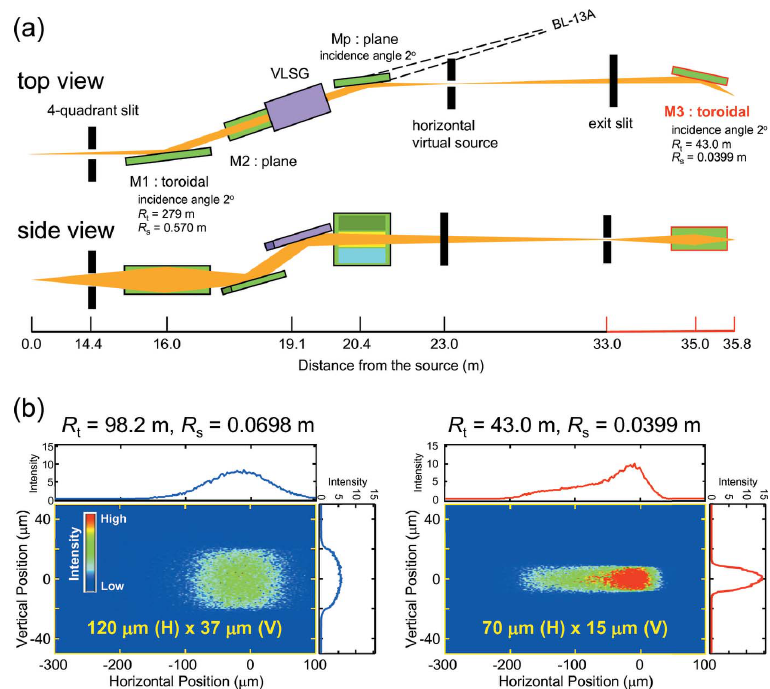
Figure 3 ( a ) Schematic optical layout of BL-13B. ( b ) Spot sizes at focal positions for the two toroidal focusing post-mirrors estimated by ray-tracing simulations. A photon energy of 100 eV, VLSG line density of 300 lines mm (cid:2) 1 , and exit-slit width of 40 m m were assumed. Integrated intensities along the vertical and horizontal axes are shown on the upper and right sides of each panel, respectively. The origin of the horizontal vertical axes corresponds to the maximum positions of the integrated peaks.